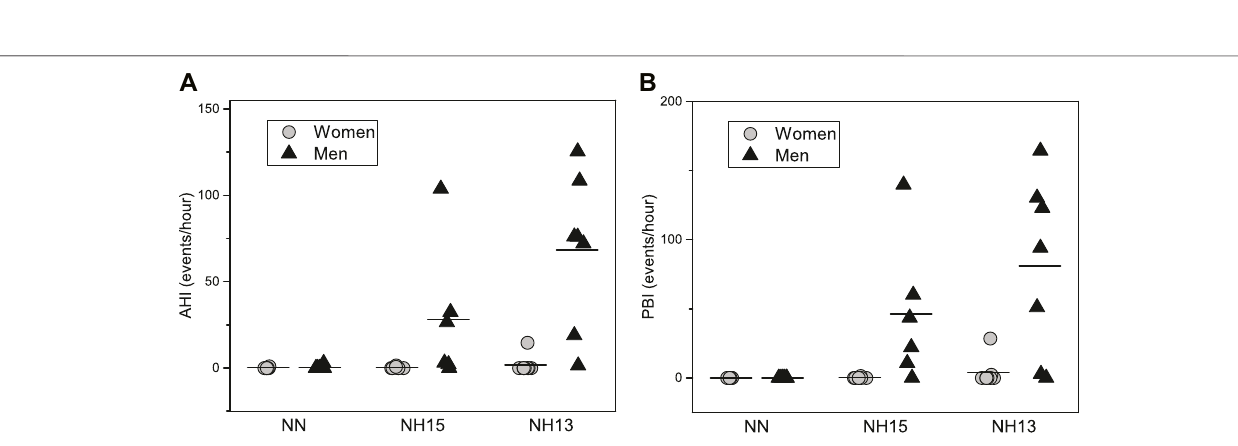
Frontiers in Physiology |